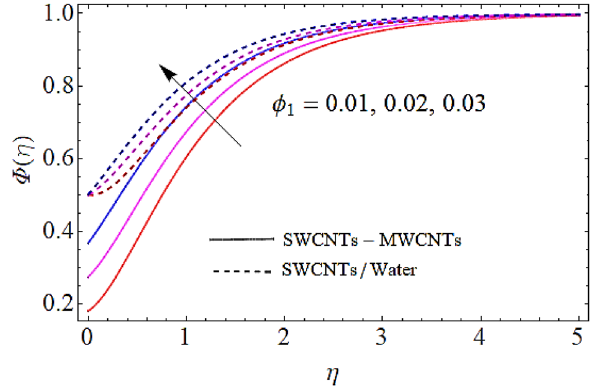
Figure 10. Concentration profile versus φ 1 when M = 0.5, φ 2 = 0.02, K = 0.7, Sc = 0.7, Pr = 12 .